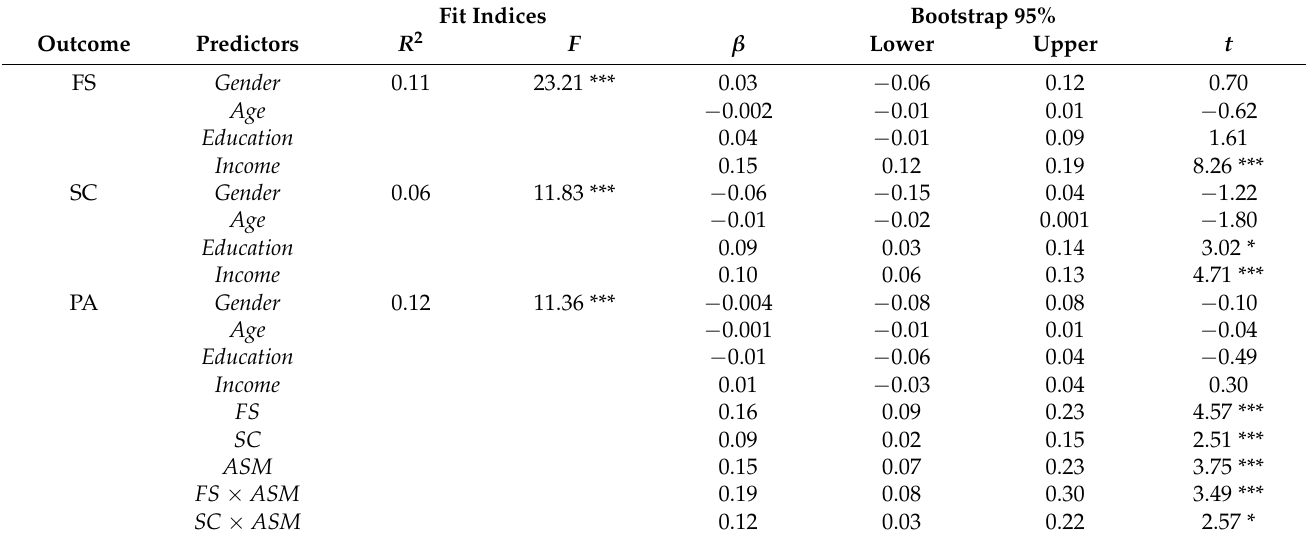
Table 9. Testing the moderated mediation effects for Positive Affect in study